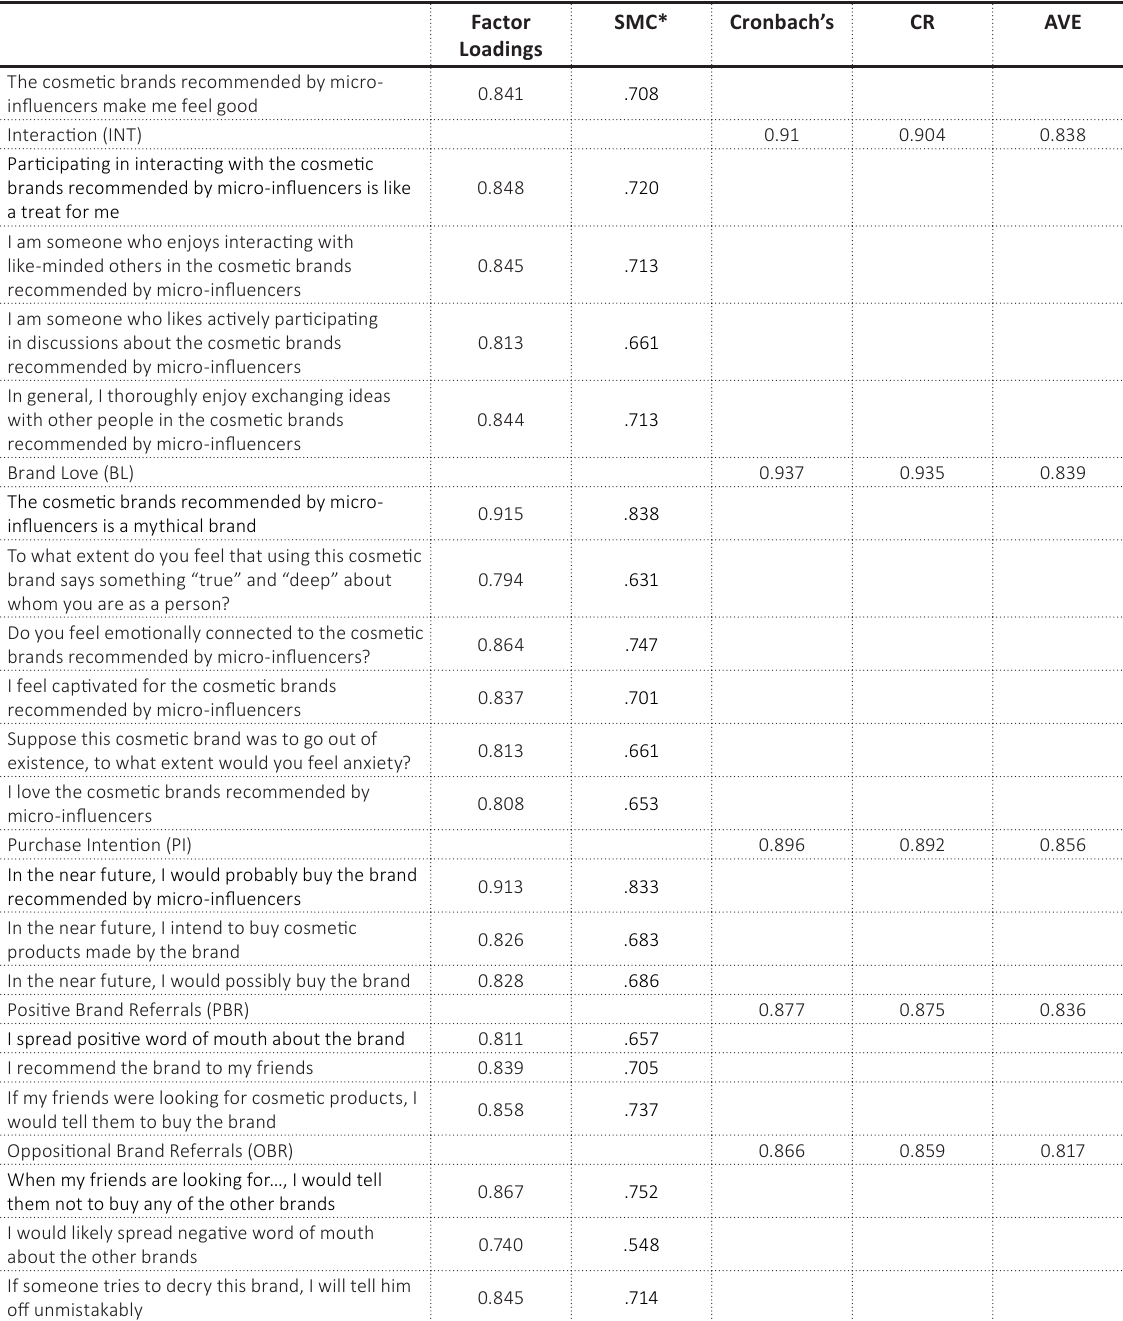
Table A1 (cont.). Confirmatory factor analysis of the final